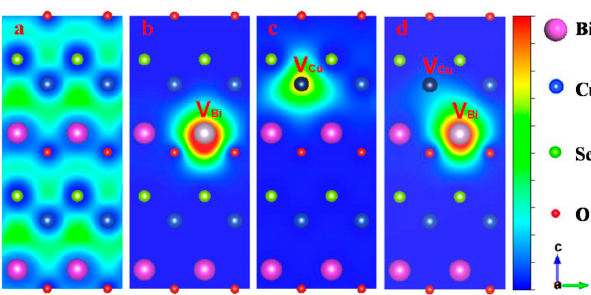
Figure 13. The projection of the positron density distribution for the (100) plane of ( a ) pure; ( b ) Bi vacancy; ( c ) Cu vacancy; and ( d ) Bi/Cu dual vacancies BiCuSeO samples. Reprinted (adapted) with permission from Reference [9]. Copyright 2015, American Chemical Society.